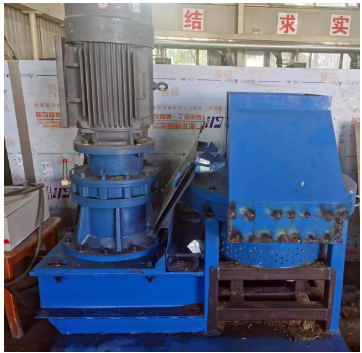
Figure 4. Biomass ring-die briquetting